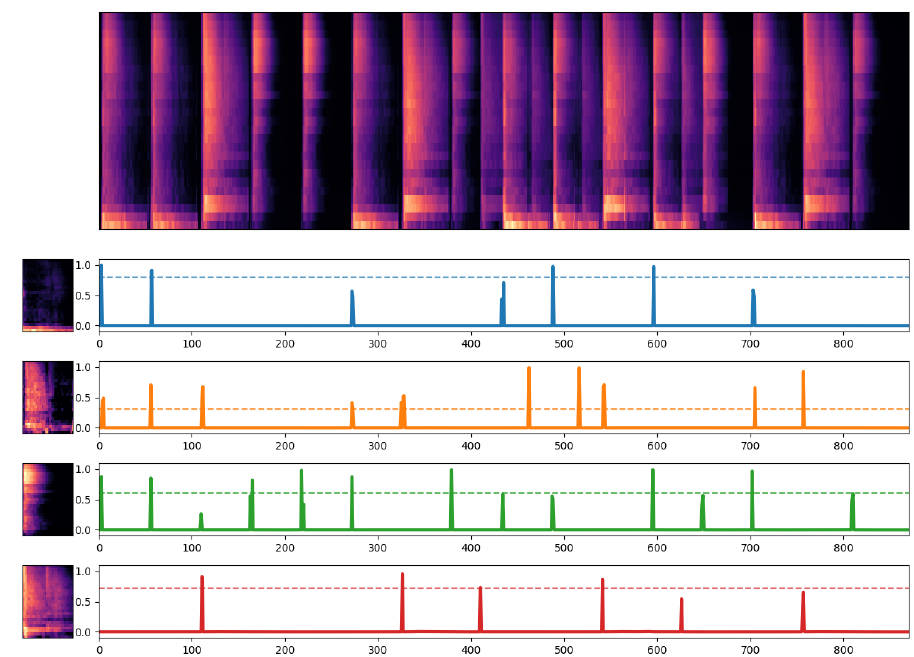
Figure 6. Decomposition of a drum loop using sigmoidal NMFD. The activations show impulse-like behavior, and each component captures different parts of the spectrogram, leading to an interpretable decomposition. The dashed line indicates the amplitude a k for each